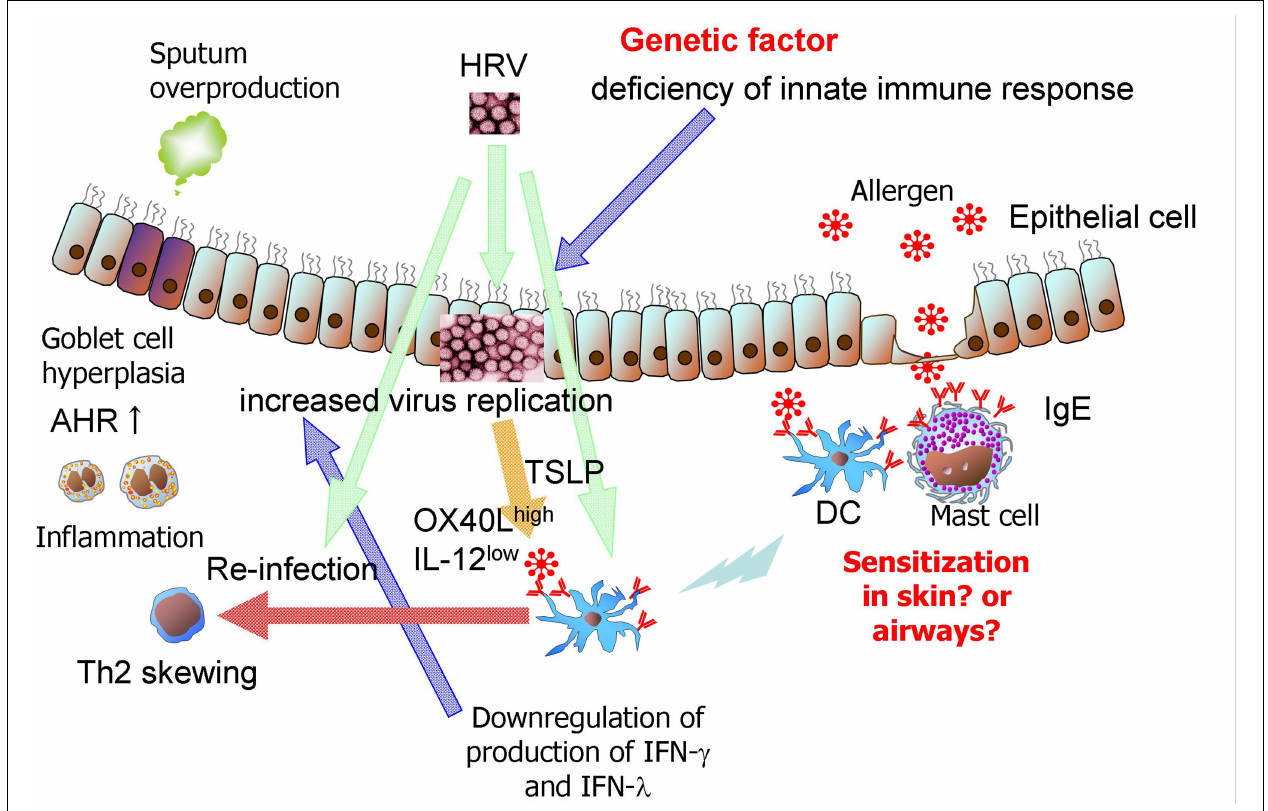
FIGURE 1 | Possible immunological mechanisms of HRV-induced bronchial asthma in infants. Sensitization to aeroallergens, beginning in the first year of life, consistently predisposes children to HRV-induced wheezing illnesses. Ongoing allergic inflammation in the airways may directly lead to impairment of the epithelial cell barrier and antiviral response. Following aggregation of Fc ε RI, HRV-induced IFN- α and IFN- λ 1 production from PBMCs and DCs is significantly reduced compared to that by HRV stimulation